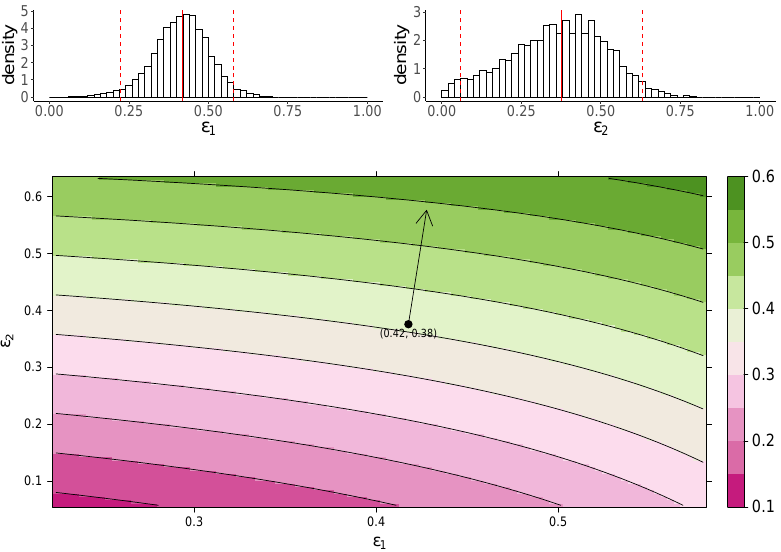
Figure 4. The dependence of the AUC M on the effects of MUC1 for the IR model. The upper panel shows the marginal posterior distribution of ε 1 ( left ) and ε 2 ( right ). The 95% credible interval (CI) for the parameters is indicated between the two red-dashed lines, and the red-solid line indicates parameters’ median value. The heatmap shows dependence of macrophage reduction efficiency on ε 1 and ε 2 . The black circle indicates the pair of median values of ε 1 and ε 2 , and the arrow indicates the direction of the rate of change in macrophage reduction efficiency at that